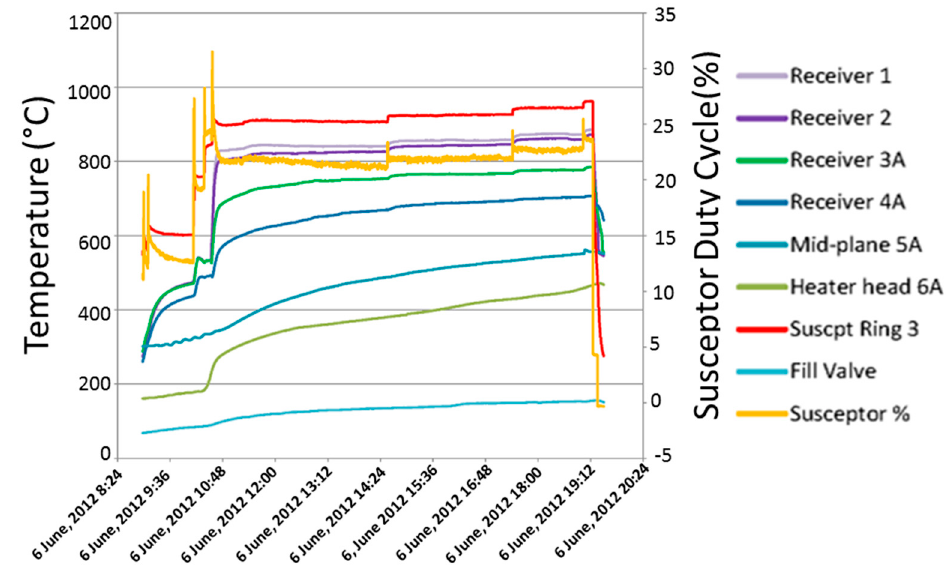
Figure 10. Temperature data from Phase I testing.